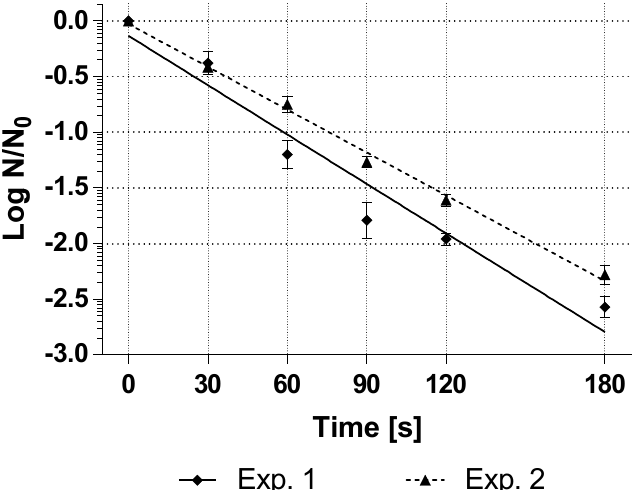
Figure 2. Inactivation curves with treatment with 35% hydrogen peroxide at 25 ◦ C (technical triplicate) of G. stearothermophilus (ATCC 7953) spores produced submerged in the bioreactor at a sporulation temperature of 57 ◦ C, sporulation pH of 7.0, and 30% minimal oxygen saturation. These spore suspensions were prepared without washing the inoculum before transferring into the sporulation medium. Some error bars are smaller than the symbols and thus not visible.